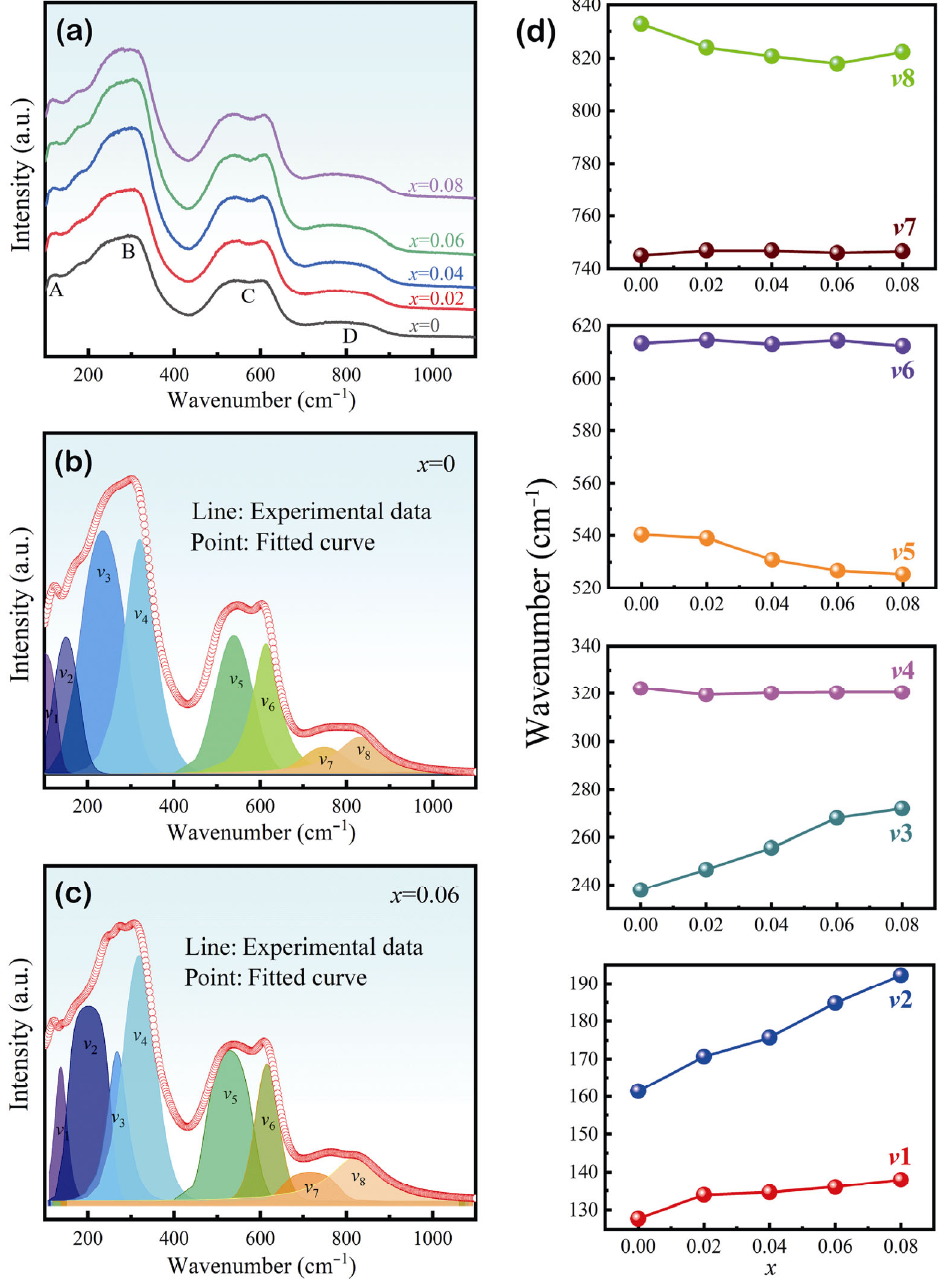
Fig. 2 (a) Raman patterns of BNS 0.245 − 1.5 x (cid:0) 0.5 x B 0.325+ x T ceramics at room temperature. Lorentz peak fitting of Raman pattern for represented BNS 0.245 − 1.5 x (cid:0) 0.5 x B 0.325+ x T ceramics with (b) x = 0 and (c) x = 0.06. (d) Wavenumbers of Raman peaks from ν 1 to ν 8 of BNS 0.245 − 1.5 x (cid:0) 0.5 x B 0.325+ x T ceramics as a function of x